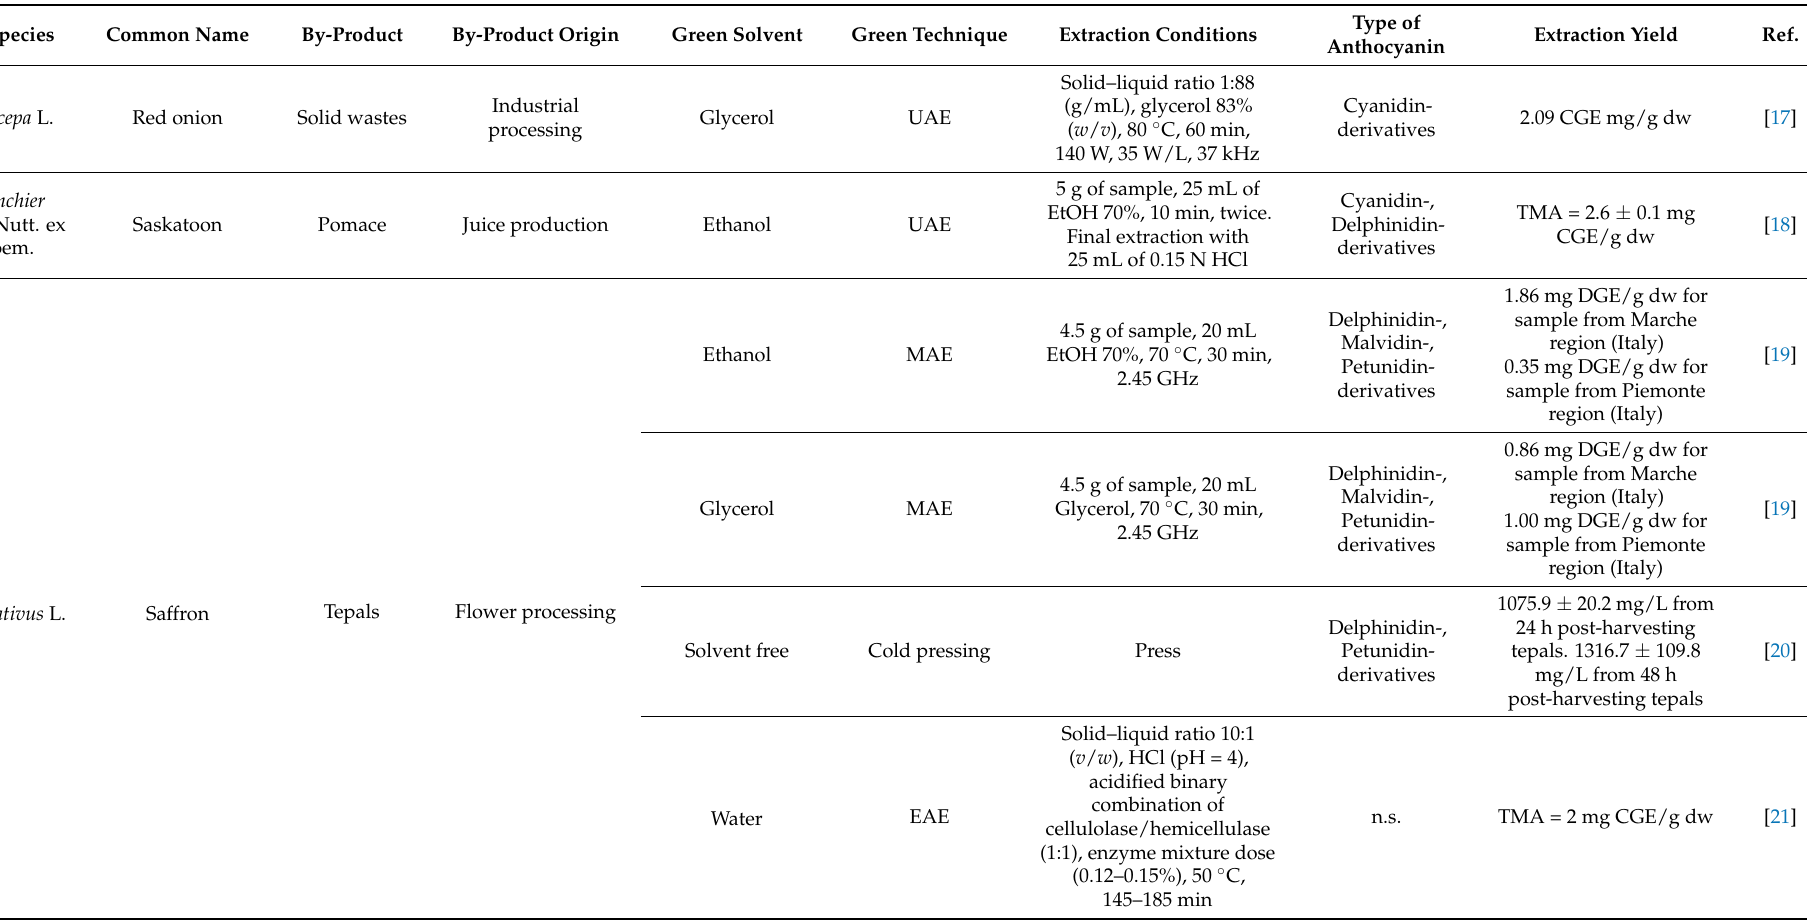
Table 1. Summary of the results emerging from the survey showing the green extraction procedures applied for recovering anthocyanins and the obtained yields. The table reports: the plant source, the by-products, the green solvents used, the green technique applied, the extraction conditions, the type of anthocyanins analyzed, the extraction yields and the corresponding